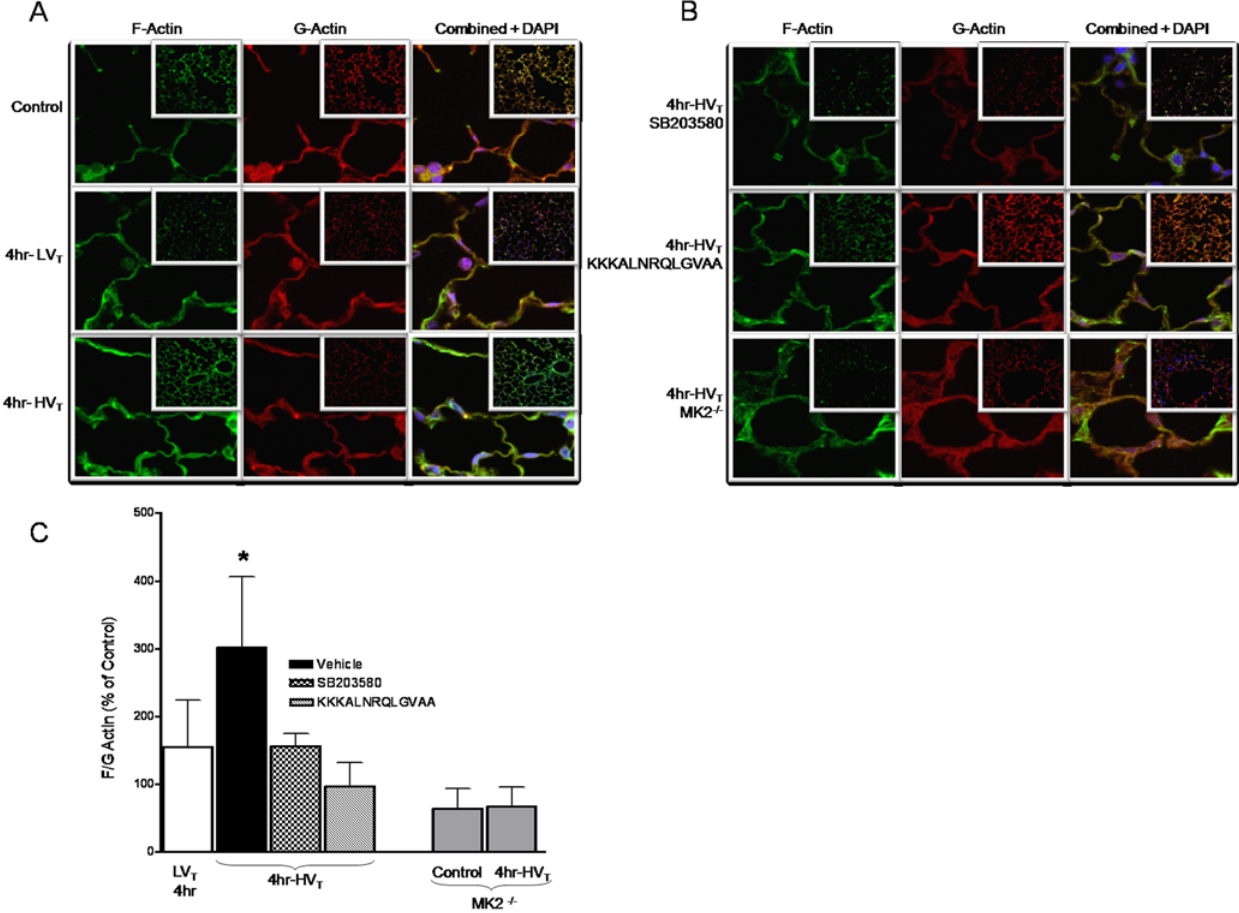
Figure 4. High tidal volume mechanical ventilation induces actin polymerization. Wild type or MK2 2 / 2 mice were randomized to spontaneous breathing or MV at LV T (7 ml/kg) and HV T (20 ml/kg) for 240 minutes (4 hrs). Lung tissue sections were prepared and stained for G- actin, F-actin and nuclei as described in the Methods section. A. Representative images (100 6 images and inset 20 6 ) from wild type spontaneously breathing (Control) mice or those exposed to MV at LV T or HV T for 4 hrs. B. Representative images (100 6 images and inset 20 6 ) from wild type mice pretreated with the p38 MAP kinase inhibitor SB203580, MK2 inhibitor KKKALNRQLGVAA or MK2 2 / 2 mice exposed to MV at HV T for 4 hrs. Images from MK2 2 / 2 mice exposed to spontaneous breathing conditions (not shown) are not different from those from mice exposed to HV T MV. C. Relative intensity of F-actin and G-actin was assessed from greater than 60 random images at low power (20 6 magnification) per condition and graphed as F- actin to G-actin ratio to represent actin polymerization. The F-actin to G-actin ratio after MV at HV T was significantly higher compared to MV at LV T or pre-treatment with SB203580, KKKALNRQLGVAA (3.02 6 1.0, 1.55 6 0.69, 1.56 6 0.19 and 0.97 6 0.34, respectively). Control represents spontaneously breathing conditions. MK2-deficient mice have a lower F-actin to G-actin ratio at baseline and are unable to polymerize actin in response to MV at HV T (0.63 6 0.29 at control conditions and 0.67 6 0.28 after MV at HV T . * P , 0.05 (vehicle vs all others). There was no statistical difference in the F-actin to G-actin ratio between MK2 2 / 2 mice under control conditions and those exposed to 4 hr of HV T MV. N=3–4 mice per